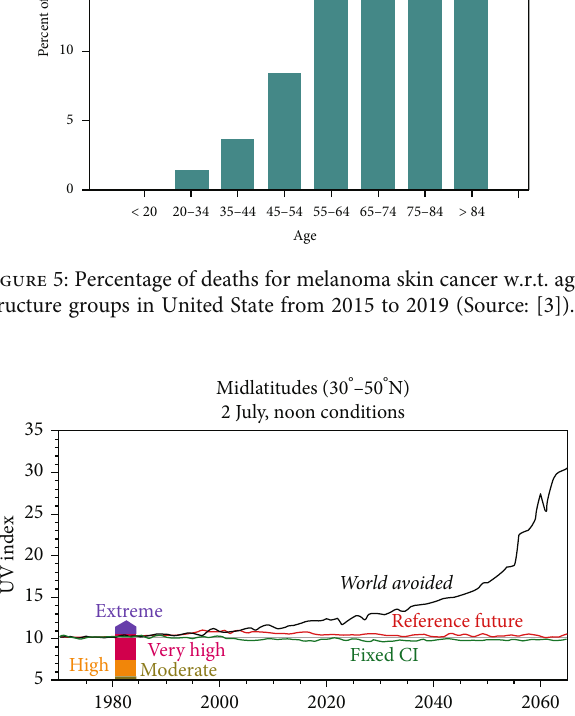
Figure 6: Behavior of UV index with ozone layer (Source: